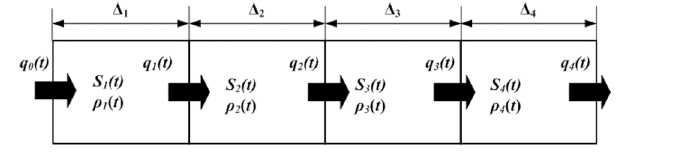
Fig 2. A typical segmented